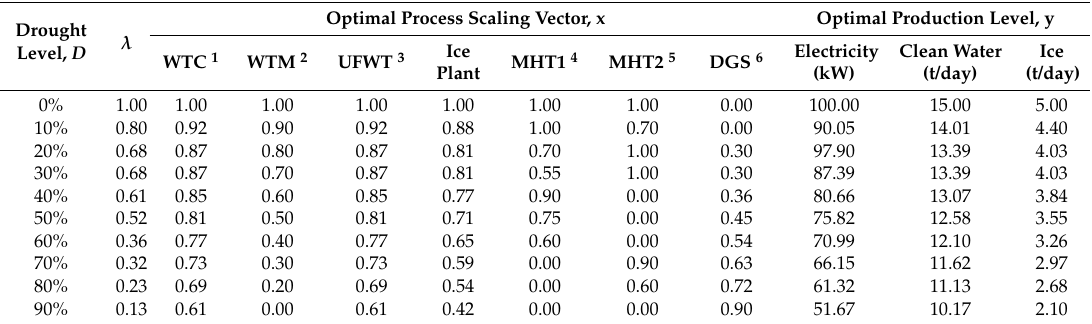
Table 6. The resulting process capacity factor and the optimal production level for case study 3. Drought Level, D